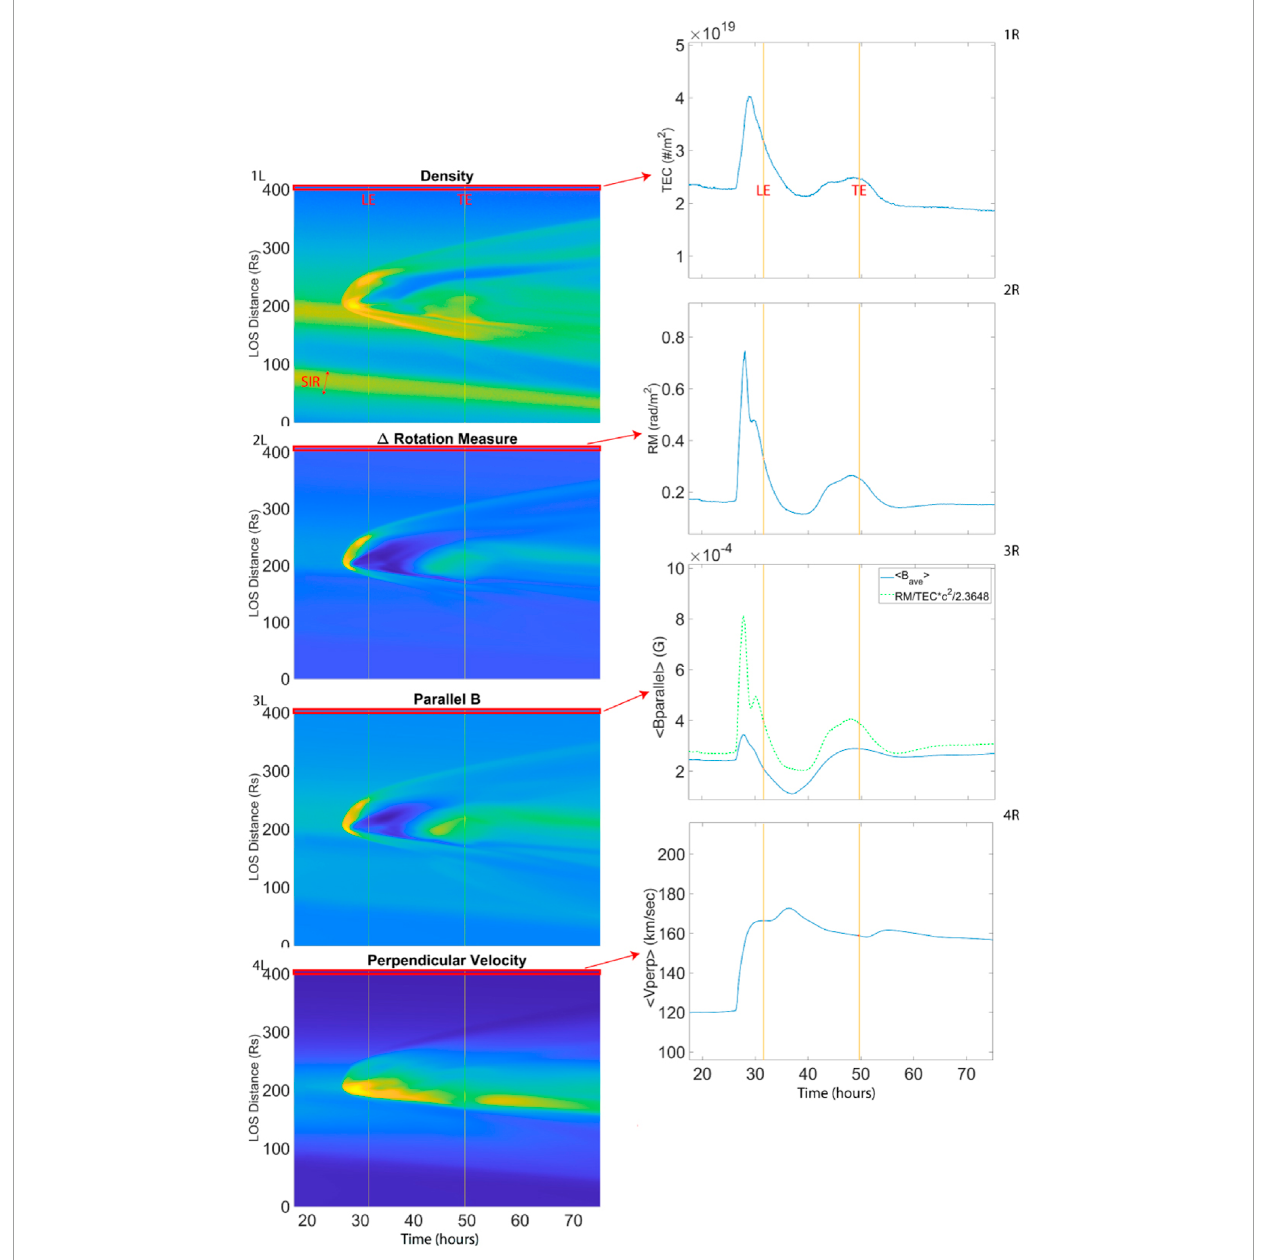
FIGURE 2 Simulated CME structure extracted along Line 3 (MOST 3 → 2) shown in a time series. The spatial distribution along the LOS of the density (panel 1L), the change in RM (panel 2L), the magnetic field parallel to the LOS (panel 3L), and the perpendicular velocity to the LOS (panel 4L) are shown to the left from the top to bottom, respectively, as functions of time. Here, the abscissa axis shows time with t = 0 since CME initiation in the AWSoM model, while the ordinate axis shows the distance along the LOS in solar radii. The plots to the right show LOS (integrated over the LOS distance) quantities. The red region is the location of the receiving spacecraft, and the arrow aids the reader to view the time profile collected at the location. From the top to bottom, respectively, we present the TEC (panel 1R), the RM observed at MOST2 (panel 2R), the average magnetic field (both modeled and calculated (panel 3R), and the average perpendicular velocity (panel 4R). LE and TE show the leading and trailing edges of the CME obtained from in situ analysis. The SIR is labeled.